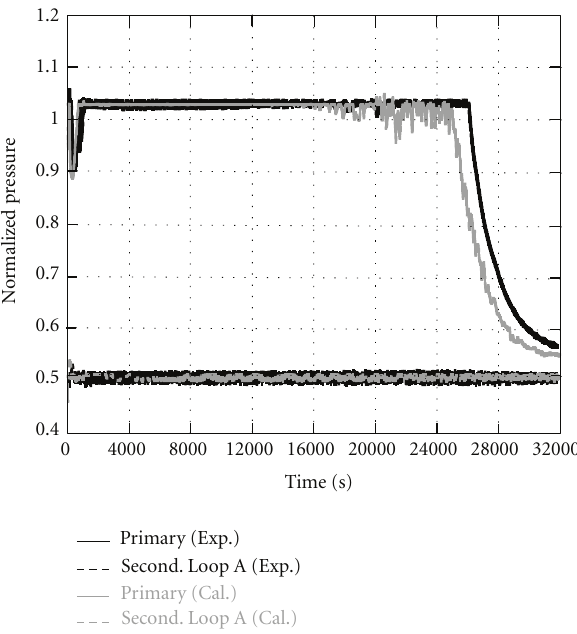
Figure 12: LSTF and RELAP5 results for primary and secondary pressures in loop with